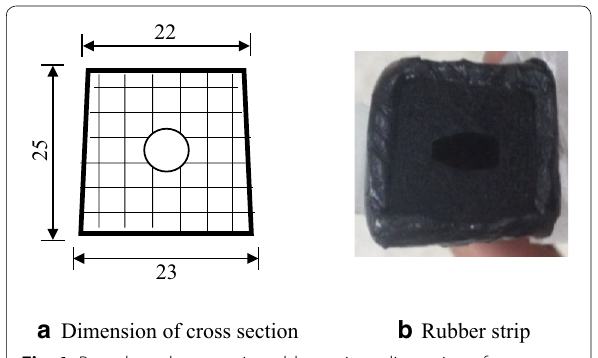
Fig. 1 Putty based composite rubber strip: a dimension of cross section; and b rubber strip (units are in